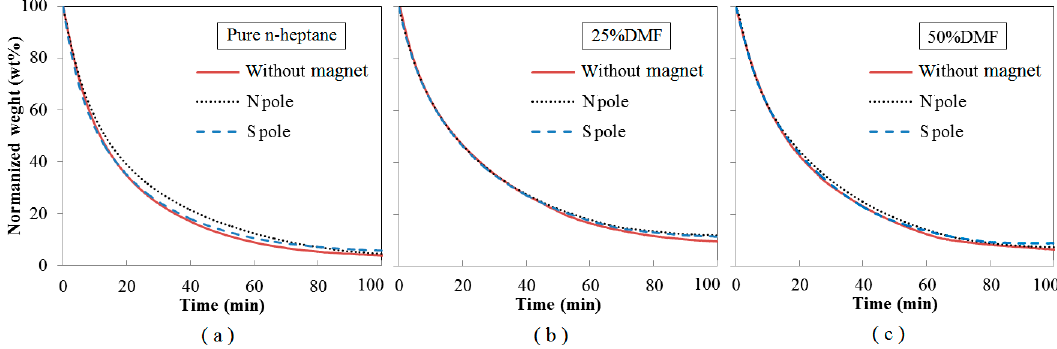
Figure 11. Comparisons of TG curves of the soot in the cases with/without magnetic fields.